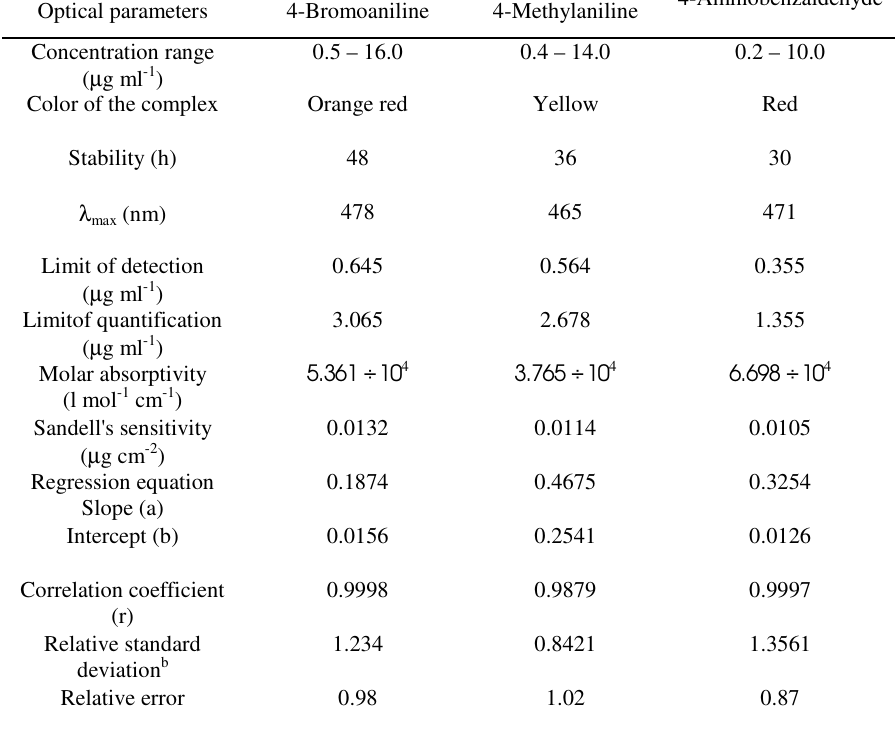
Table 1. Optical characteristics, precision and accuracy of the method using diazotized reagents. Optical